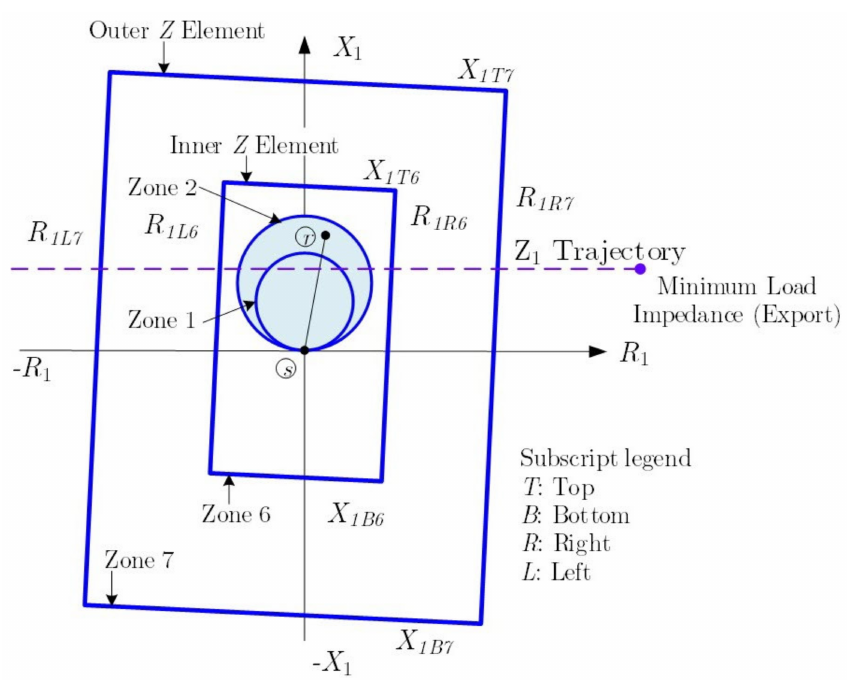
Figure 8. Inner and outer zone (Zone 6 and Zone 7) used for OOS power-swing detection. Phase distance ets Zone 1 and Zone 2 are depicted.